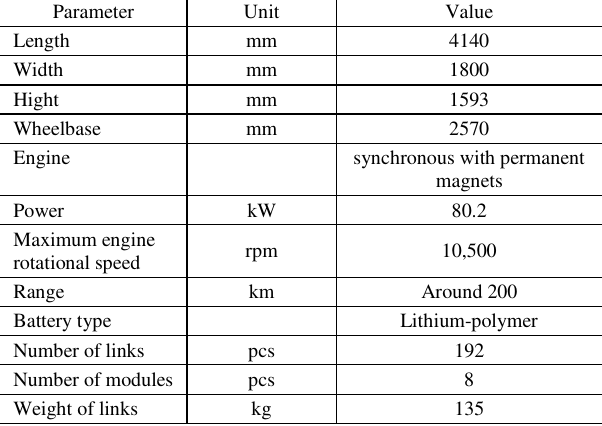
Table 2. Selected technical data of the tested EV vehicle [2]